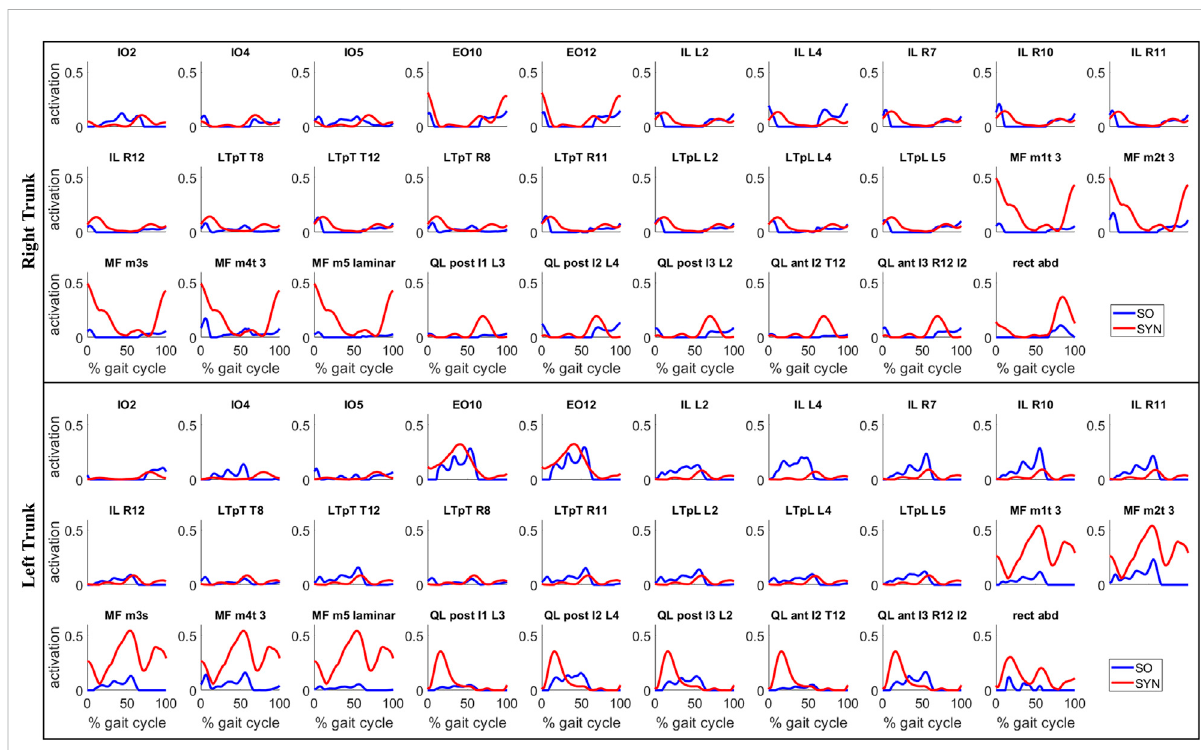
FIGURE 5 Estimates of trunk muscle activations by the proposed synergy-based method (SYN) and by the static optimization method (SO) for a representative gait cycle. For SYN, the activations were estimated with 7 muscle synergiesper side and Allow a (cid:1) 0 . 50. The name above each subplot indicates an individual muscle head, and the larger muscle to which each muscle head is associated is listed in Table